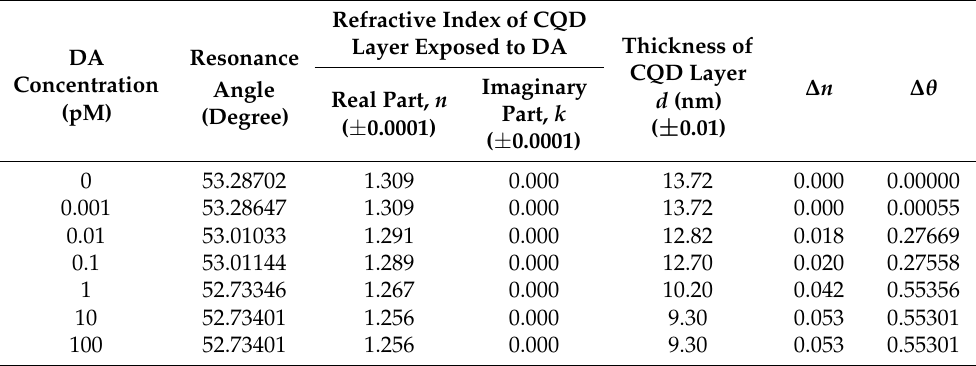
Table 1. The resonance angle, refractive index, and thickness values for CQD film determined by fitting experimental SPR curves to the theoretical, change in the real part of the refractive index ∆ n , and change in the resonance angle ∆ θ . Refractive Index of CQD Layer Exposed to DA Thickness of Resonance DA Concentration Angle (pM) (Degree)